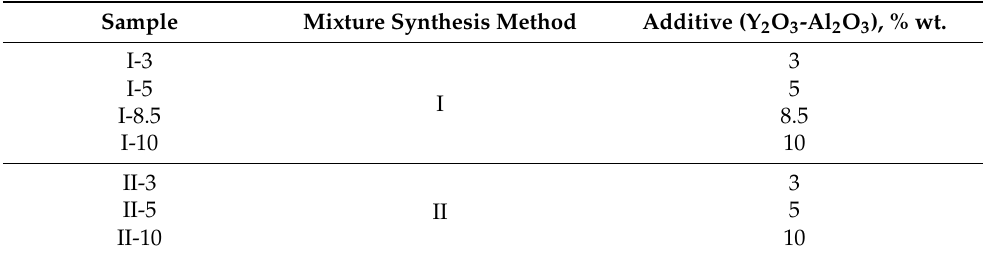
Table 1. Description of powder